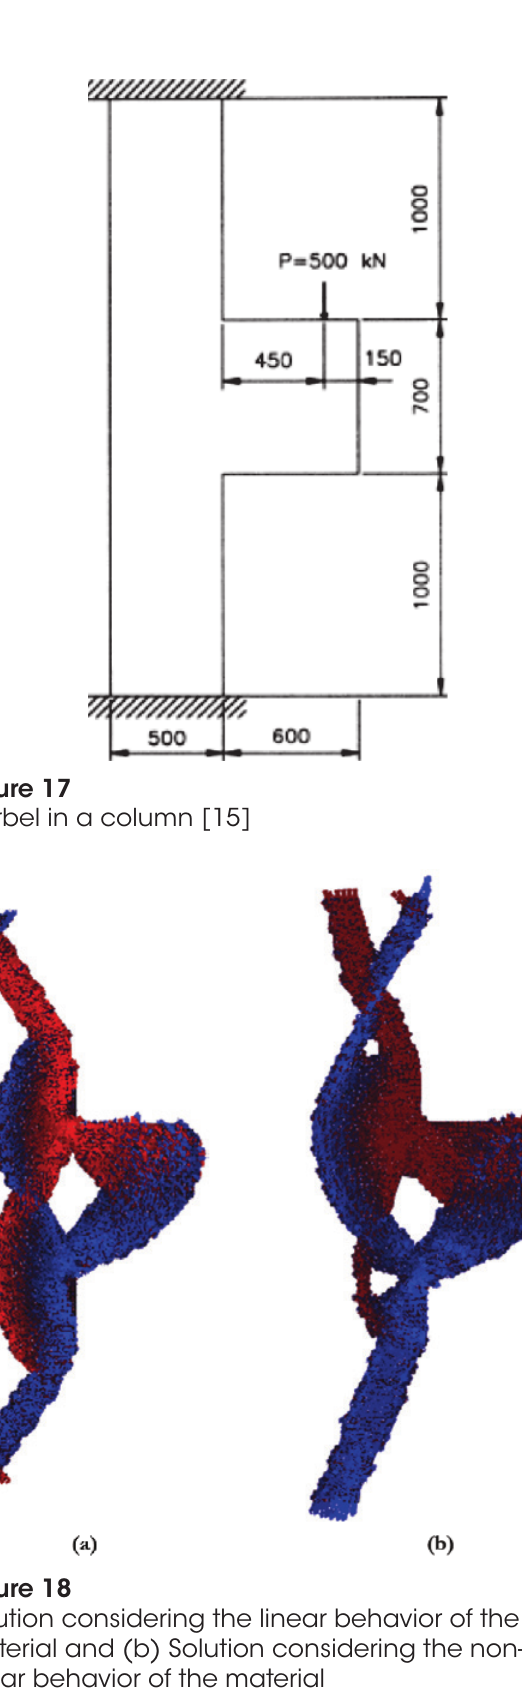
Reinforcement sketch for Example 2